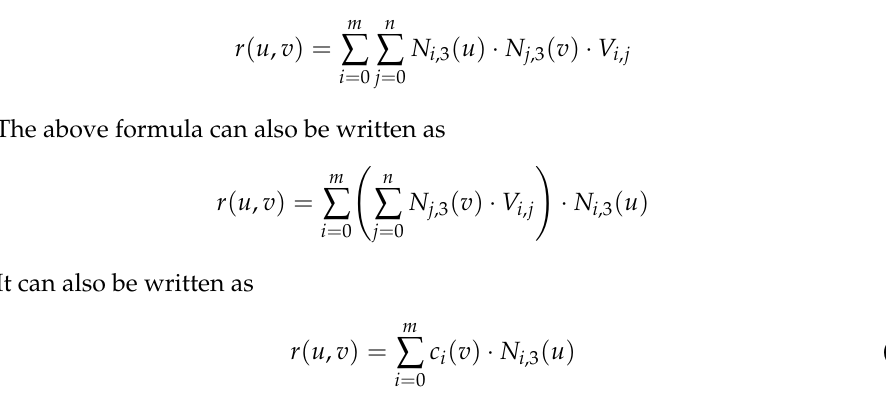
the engine axis and the Y axis is positively determined based on the right-hand rule. Thus, for the to-be-cut blade surface, a series of section planes would intersect with the blade surface. The intersection profile is the profile curve which is perpendicular to the Z axis. The optimization constraints are judged within the blade sections. If the to-be-cut blade surface is covered by the blade billet and inside the profile tolerance band on all blade sections, it would be an available surface. Therefore, the profile curves on the blade sections need to be calculated (Figure 6). The profile curve in this paper is calculated by the Newton iteration method.